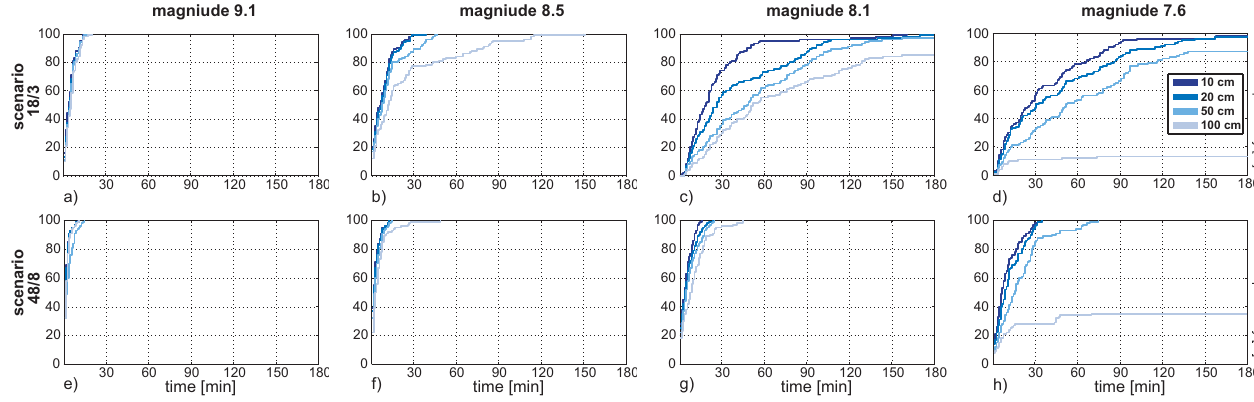
Fig. 11. Tsunami detection probability functions for the scenarios 18/3 in the upper row and 48/8 in the lower row, all with 60 ◦ inclina- tion angle, 900km altitude, and applied to four tsunami events with earthquake M 9.1, 8.5, 8.1, and 7.6 (Table 2). Altimetric sensitivity assumptions are varied between 10cm, 20cm, 50cm, and